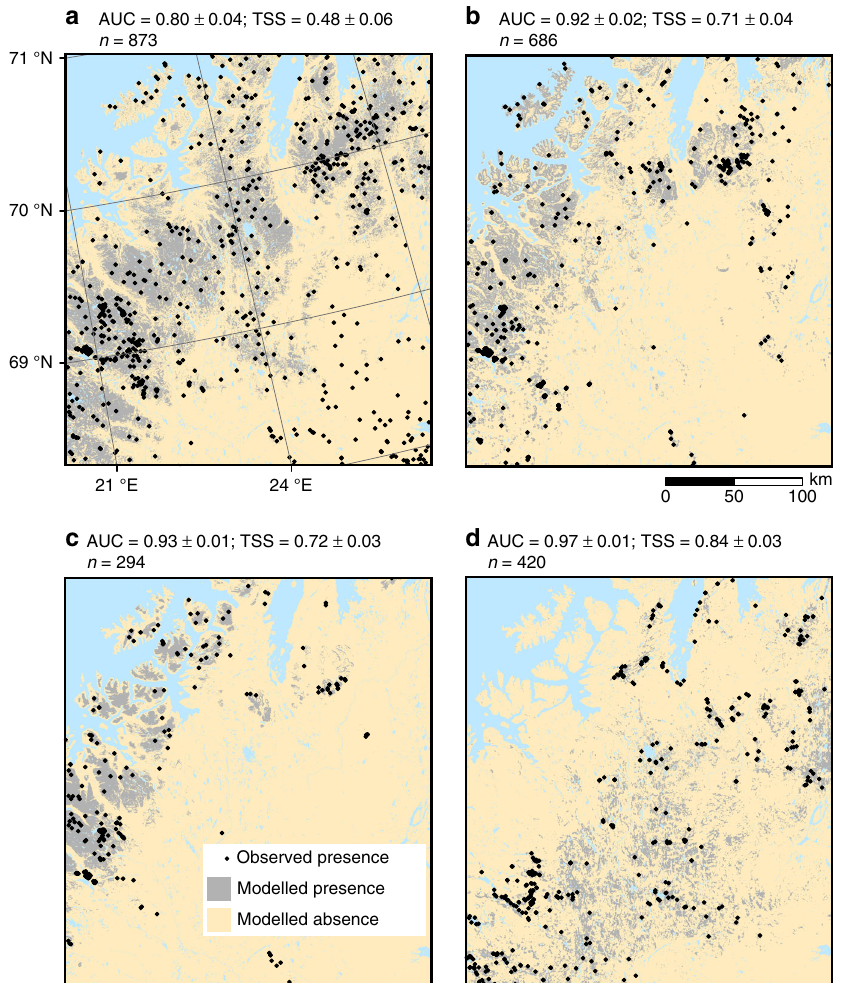
Fig. 2 The modelled baseline occurrences of the four LSPs based on majority vote ensemble. The n in the title denotes the number of observed presences ( black dots ), while all the observation sites ( n = 2,917) are presented in Fig. 1c. The modelling performance is measured as the area under the curve of a receiver operating characteristic plot (AUC) and the true skill statistics (TSS). The evaluation statistics show the mean ( ± s.d.) over four modelling techniques and 100 cross-validation runs conducted for each LSP ( a cryoturbation, b geli fl uction, c nivation and d permafrost mounding) using a